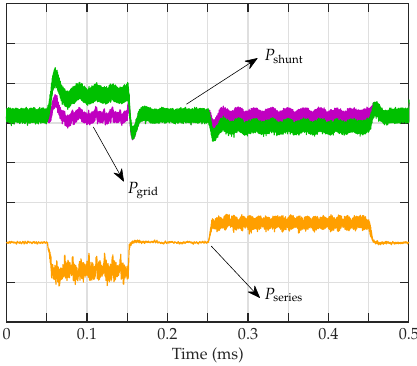
Figure 12. Instantaneous power flow with 15% sag from 0.05s to 0.15s and 10% swell from 0.25s to 0.45s—simulation results.